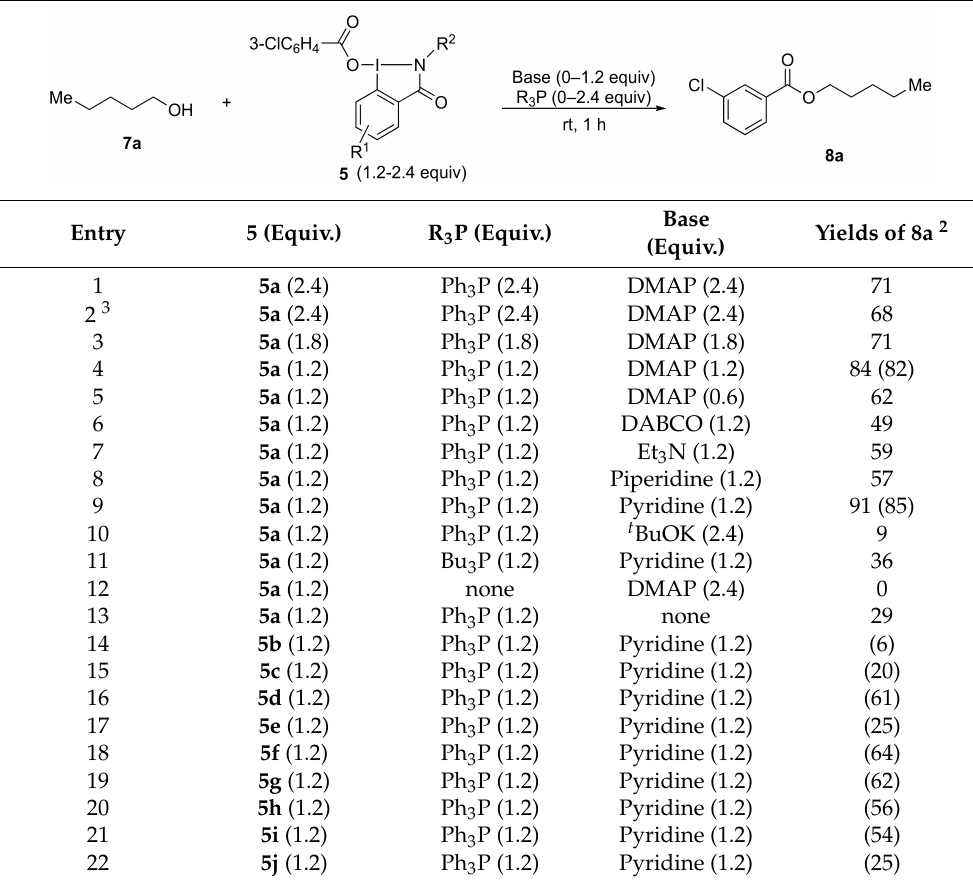
Table 1. Optimization of the condensation of n- pentanol 7a using benziodazolone 5 conditions 1 .